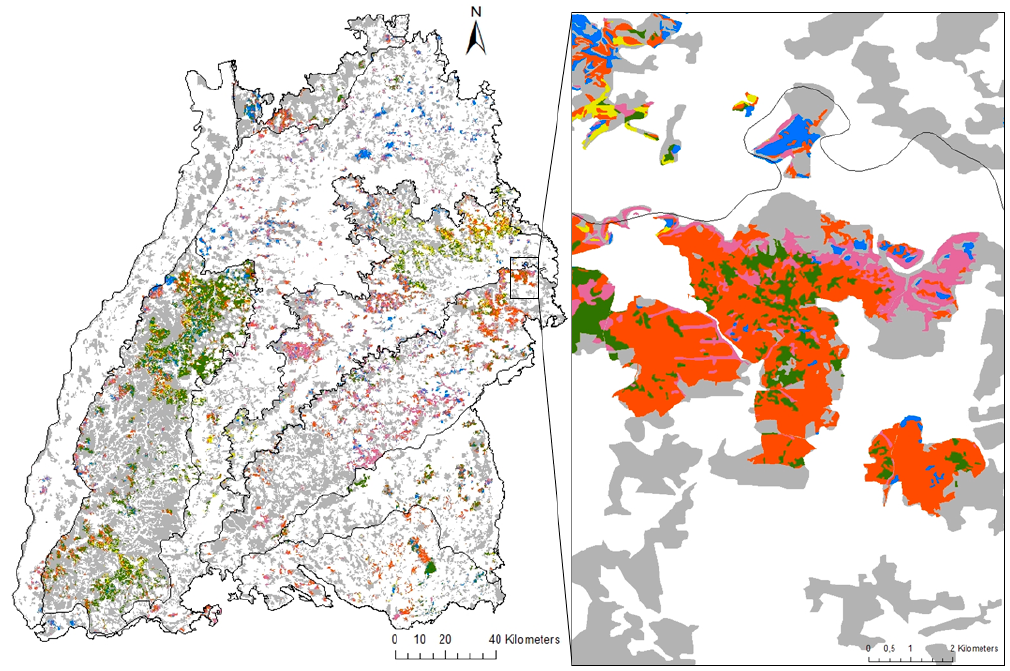
Figure 4. Location of the Forest Development Types (FDTs) in 2050 in BW state forests. In green: Coniferous-beech-mixed forests (FDT 1); in red: Beech-coniferous-mixed forests (FDT 2); in yellow: Reduced risk spruce forests (FDT3); in brown: Silver fir forests (FDT 4); in blue: Oak-mixed forests (FDT5); in pink: Beech-broadleaved forests (FDT6); in grey: Whole BW forest.